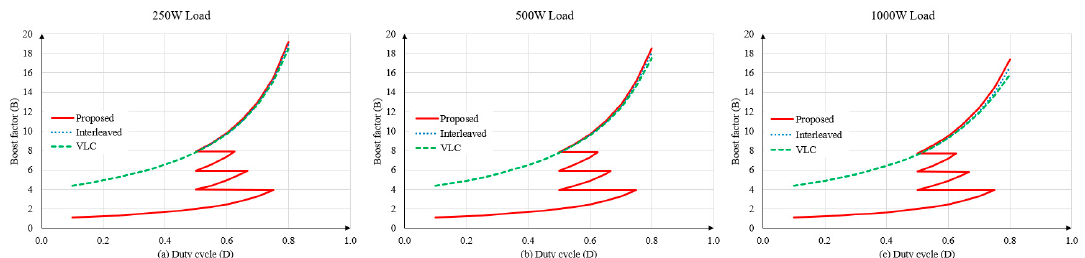
Figure 13. The comparison of boost ratio B with Po = 250 W ( a ), 500 W ( b ), 1000 W ( c ).